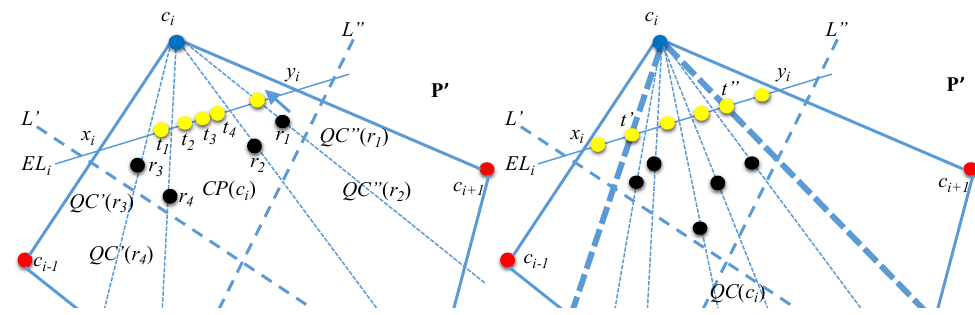
Figure 12. An illustration of how the interior robots of P (cid:48) move to the eligible lines during Stage 1.2.2. The details are as follows. Let r i be the first robot with color internal to be activated after all the corners of P (cid:48) are colored corner3 , corner5 , or corner with at least a corner colored corner3 . Let r i be closest to corner c i of P (cid:48) than any other corner of P (cid:48) . Robot r i